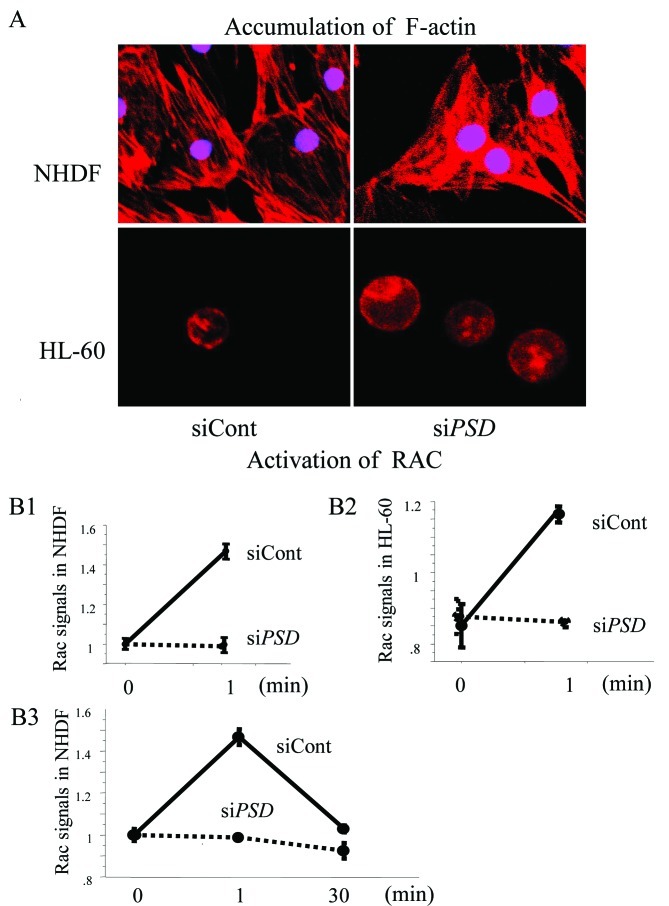
(A) Rhodamine-labeled actin (red) polymerizes preferentially at the edge of lamellipods in siControl-treated NHDF and HL-60 cells (left) after stimulation with EGF, whereas rhodamine-labeled actin remained inside the plasma membrane in siPSD-treated NHDF and HL-60 cells (right). Nuclei were stained with Hoechst 33342 (pink). (B) Rac1 signaling before and after stimulation with EGF in siControl-treated and siPSD-treated NHDF cells (B1) and in siControl-treated and siPSD-treated HL-60 cells (B2). (B3) Rac1 signaling declined to basal levels by 30 min after stimulation.